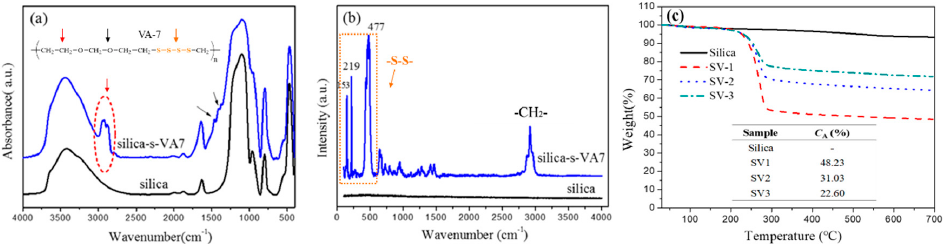
Figure 2. ( a ) Fourier transform infrared (FTIR) spectra, ( b ) Raman spectra of silica and silica-s-VA7, and ( c ) thermogravimetric analysis (TGA) curves of silica, SV1, SV2, and SV3.